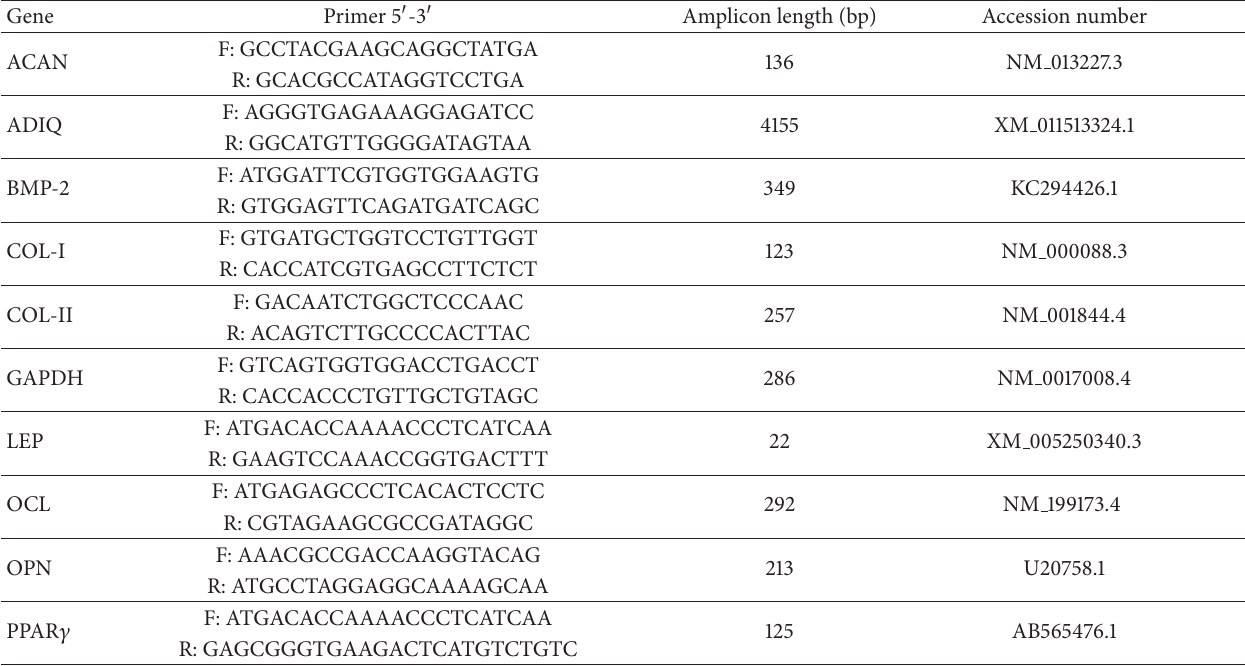
Table 1: Primer sequences used in